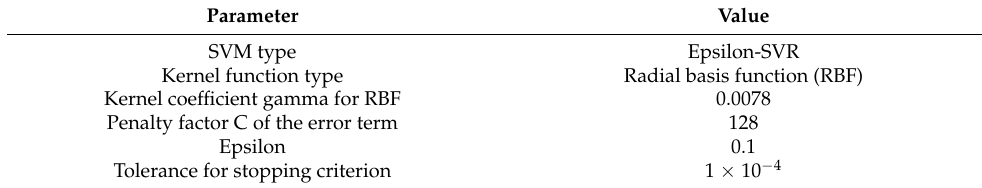
Table 8. Structure of the SVM regression model.